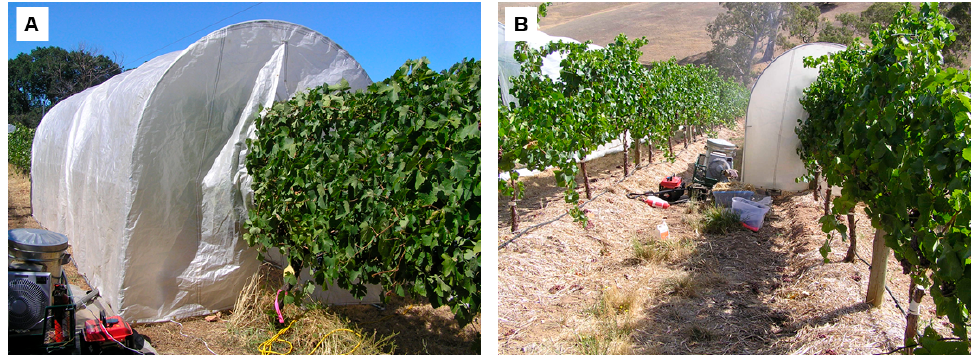
Figure 1. Grapevines were enclosed in a tent, and smoke from combustion of straw was blown into the tent using a fan. Pre-installation of the tent ( A ), and installed and operational tent ( B ). Photos obtained from the 2009/10 trial in Adelaide,